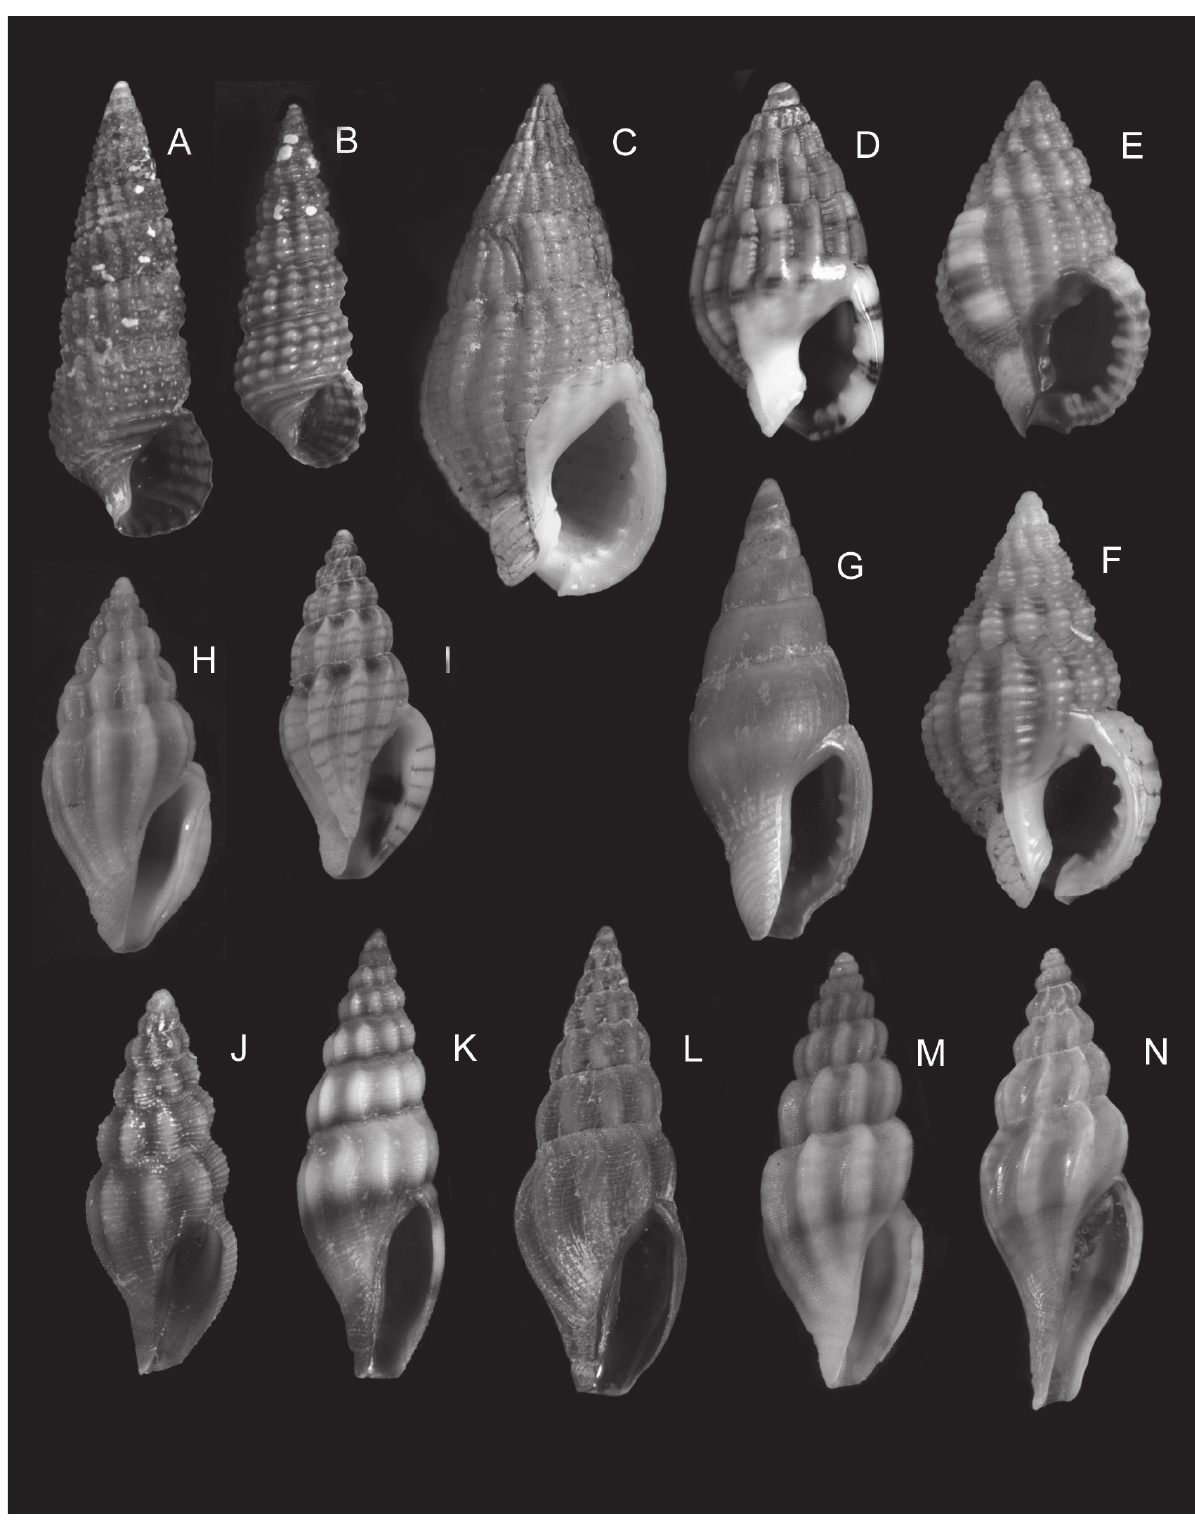
Fig . 3. – Prosobranch gastropods of the sediment and the leaf stratum in Zostera marina . apertural views of: a, Bittium latreillii (shell height: 7.4 mm); B, Bittium reticulatum (3.8 mm); C, Nassarius reticulatus (12.2 mm); d, Nassarius cuvierii (7.7 mm); e, Nassarius pygmaeus (8.7 mm); f, Nassarius incrassatus (10.2 mm); g, Mitrella minor (9.2 mm); H, Mangelia unifasciata (8.3 mm); i, Mangelia paciniana (6.1 mm); J, Bela sp. 1 (5.8 mm); K, Bela laevigata (9.9 mm); L, Bela nebula (8.5 mm); m, Bela costulata (7.7 mm); n, Man- gelia attenuata (8.1